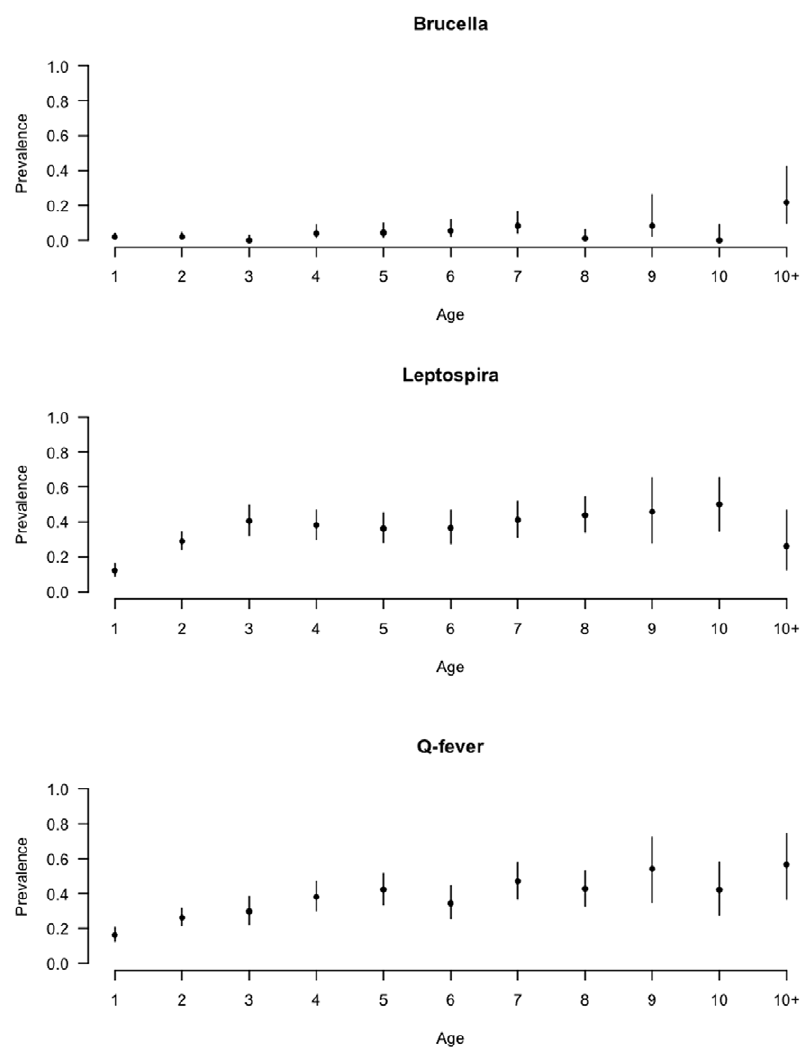
Figure 3. Age stratified animal-level seroprevalence based on raw test results (not adjusted for clustering within herds or diagnostic test imperfections).